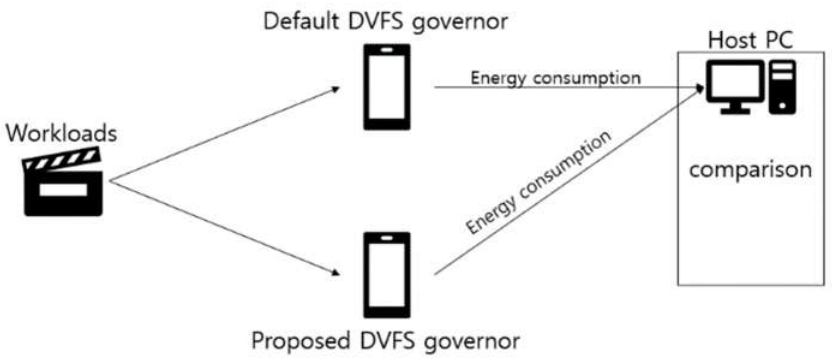
Figure 9. Experimental environment.